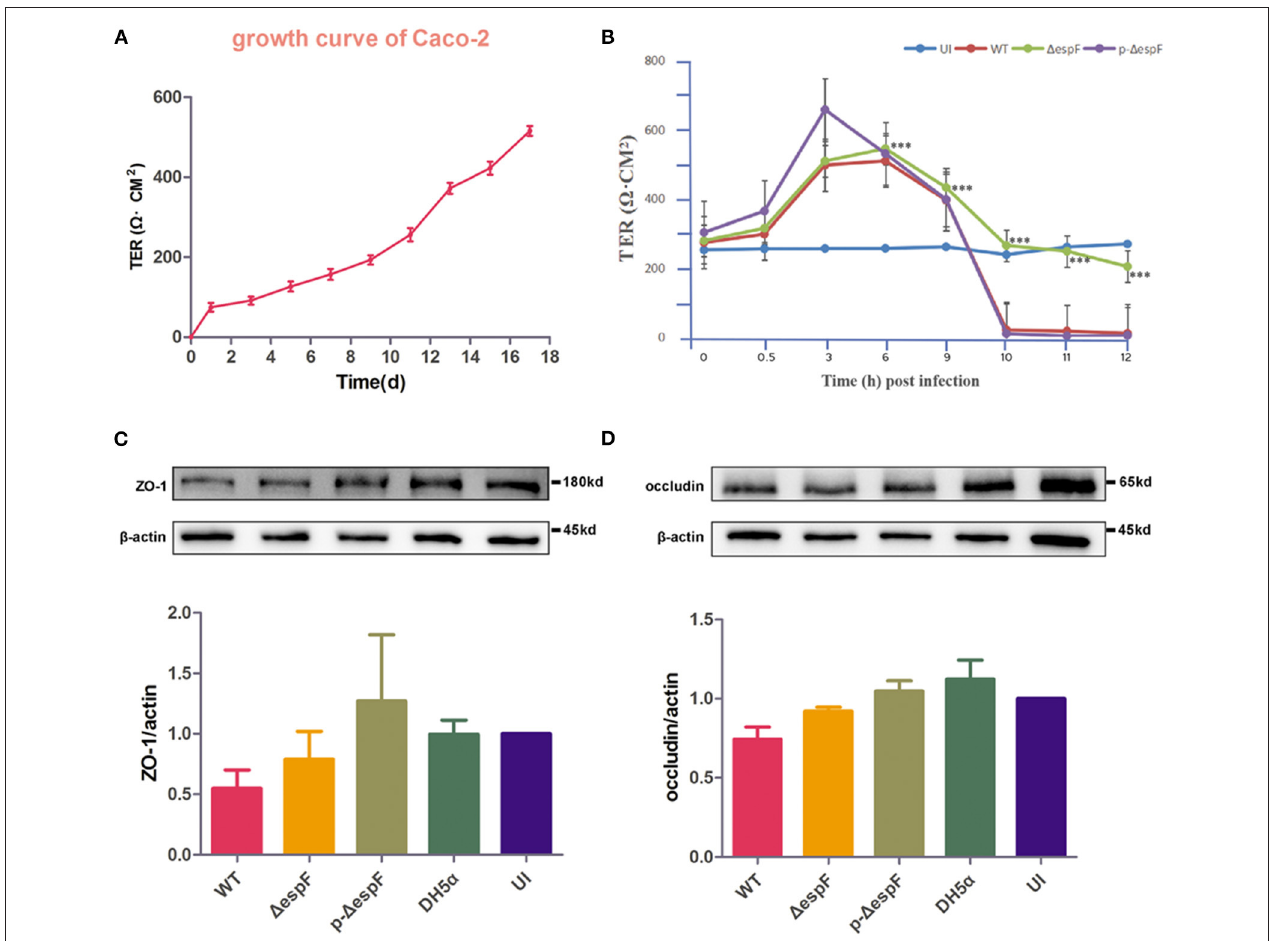
FIGURE 7 | Schematic diagram of changes in TER and expression level of ZO-1 and occludin in Caco-2 cells infected with EHEC O157:H7. (A) TER growth curve of Caco-2 cells. (B) The curve of TER value in Caco-2 cells infected with EHEC EDL933w strains (WT), espF -deficient strains ( 1 espF ), and espF -complementation Strains (p- 1 espF ). Data are presented as means ± SD from three independent experiments. *Statistically significant difference. *** p < 0.001. (C,D) Schematic diagram of TJ protein expression levels and grayscale analysis of WB strips in Caco-2 cells infected with WT, 1 espF , p- 1 espF, and DH5 α . The grayscale analysis was performed by ImageJ software. Error bars represent means ± SD from three independent experiments. UI, uninfected